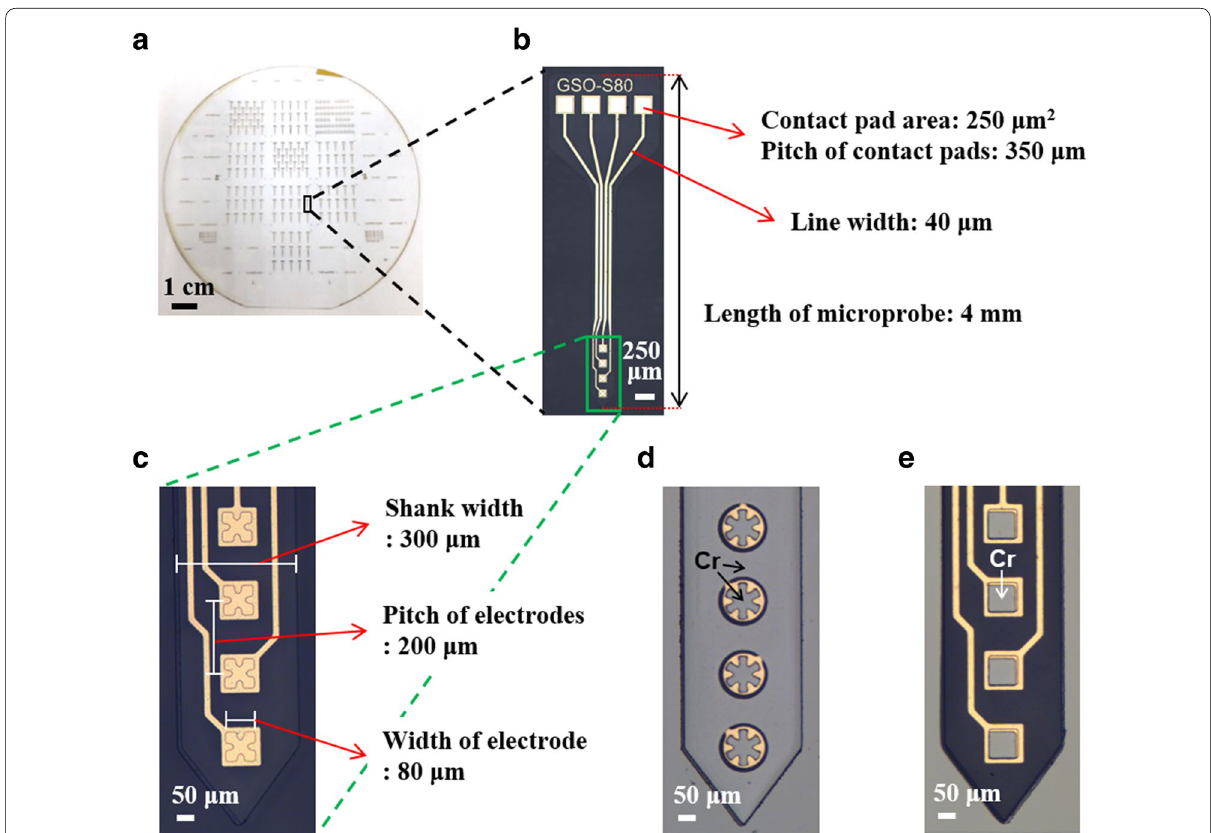
Fig. 3 Fabricated microprobe without or with a nanostructured surface. a Photograph of SU‑8 microprobes on a 4‑inch glass wafer. b Enlarged optical image of the microprobe in ( a ) and c a representative optical image of gold electrode on the microprobe surface in ( b ). d Asterisk shape electrode and e square shape electrode of the microprobe masked with chromium (Cr) for